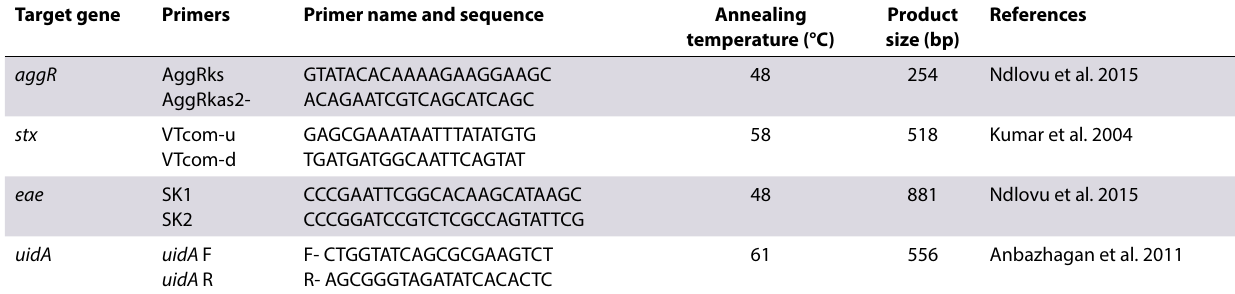
Table III: Primer sequences, annealing temperatures and predicted sizes of amplicons for E. coli Target gene